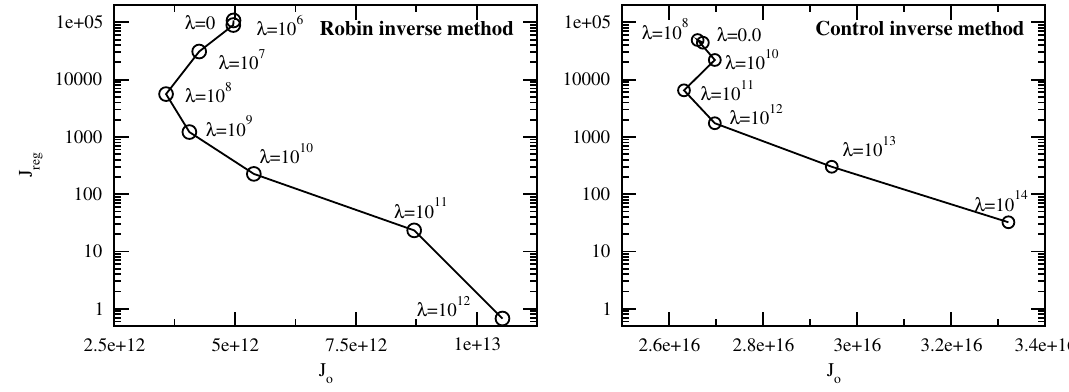
Fig. 3. L-Curve obtained with the Robin (left) and Control (right) inverse